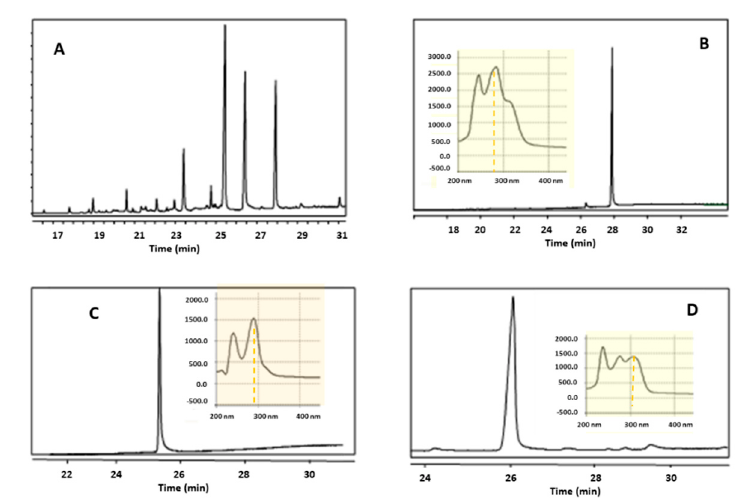
Figure 3. Representative GC-MS analysis of ( A ) crude alkaloids of Rhodolirium speciosum and CPC isolated main compounds. ( B ) Alkaloid 1, ( C ) Alkaloid 2 and ( D ) Alkaloid 3. UV-VIS spectra depicted in the insets were obtained directly from the preparative PDA detector of the CPC apparatus.